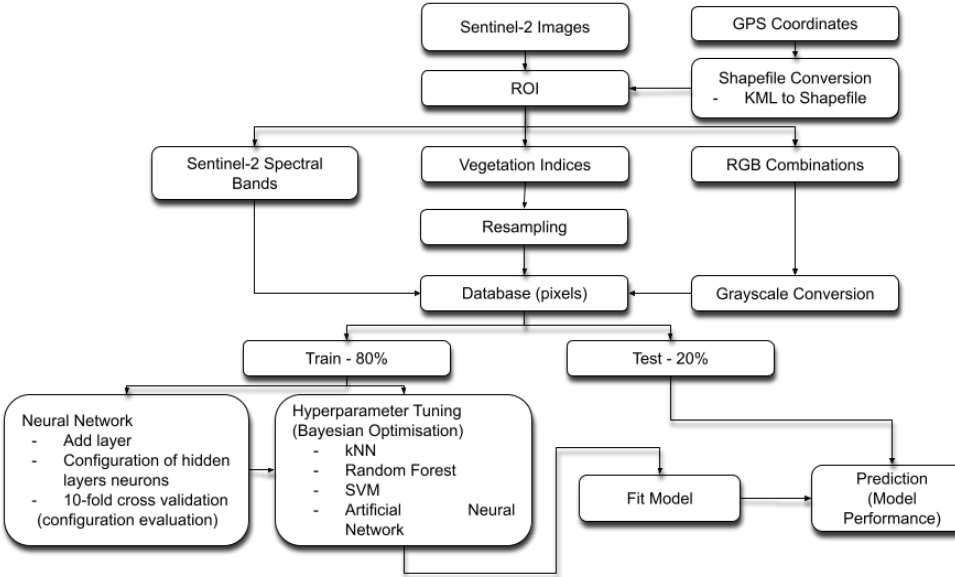
Figure 3. Flowchart for classifying sugarcane